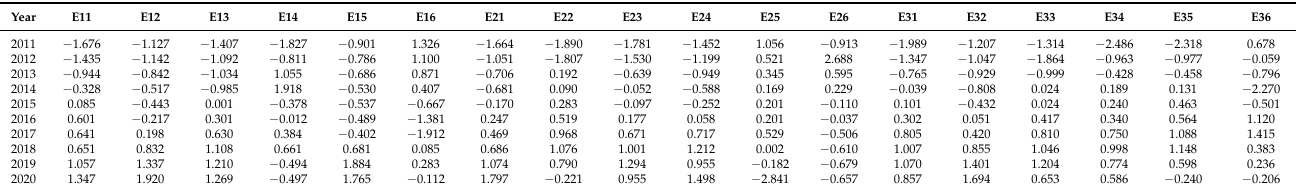
Table A1. Sequence parameters standardized values of ESE-B composite